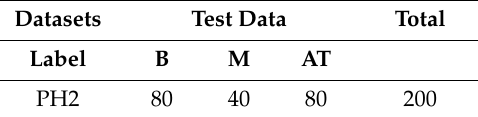
Table 1. Distribution of PH2 dataset.